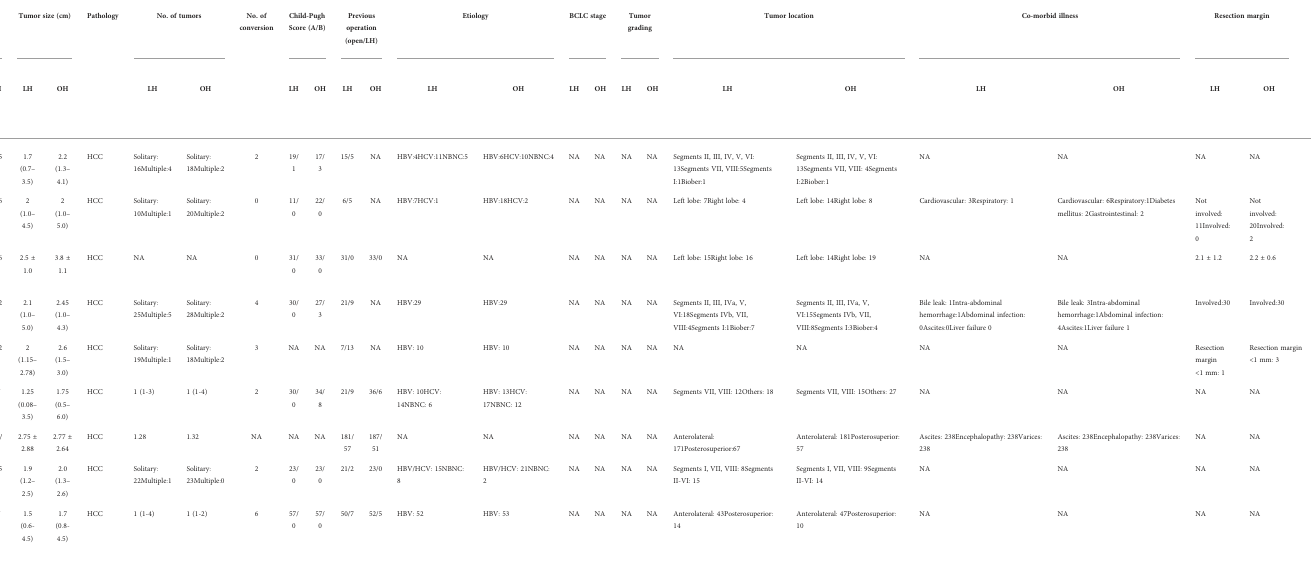
TABLE 1 The main characteristics of the included studies in this